Question: Write the caption for this figure.
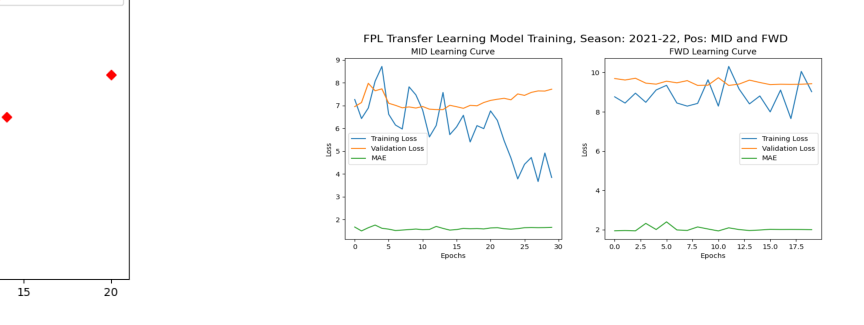
Answer: Learning curve and metrics for MID and FWD.